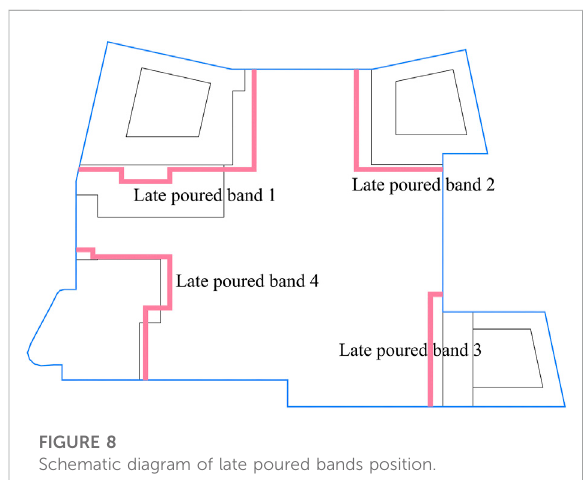
FIGURE 8 Schematic diagram of late poured bands